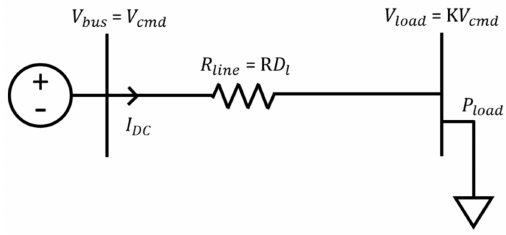
Figure 3. Impedance diagram of a simplified DC microgrid.